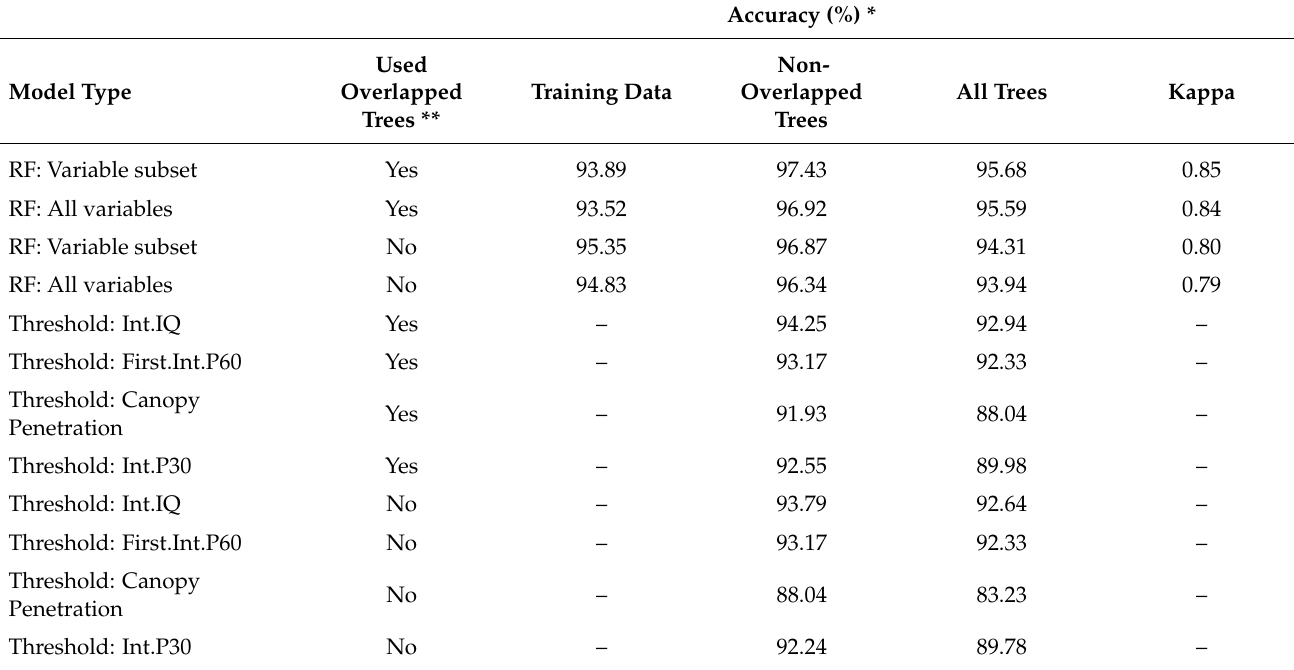
Table 1. Comparison of model performance for random forest and simple threshold models. Random forest models were fit 30 times with different data splits for training and testing data and different random number seeds for each model run. Accuracy was averaged for the 30 models. The Kappa coefficient represents the average for the 30 models when applied to all